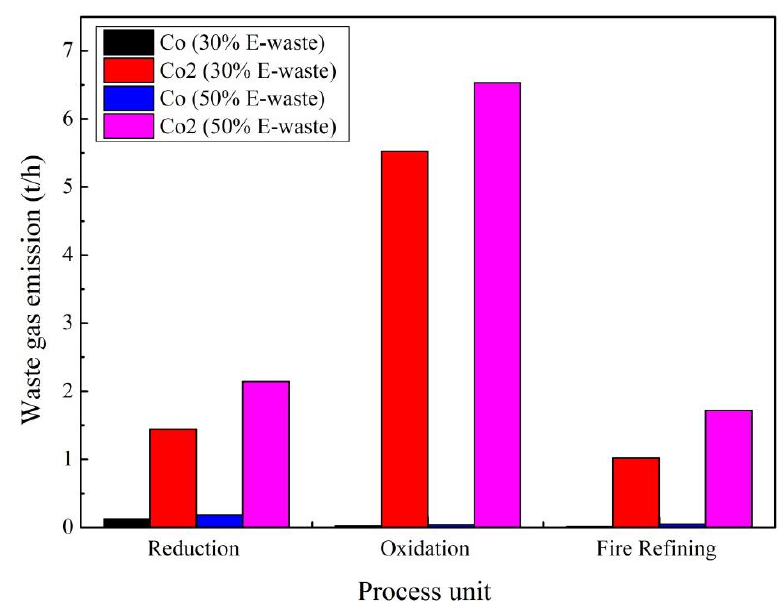
Figure 7. Waste gas emission rate (t/h).